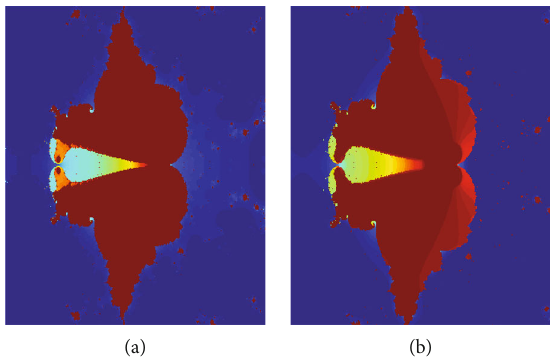
Figure 12: E ff ect of change in parameters T , t , and u